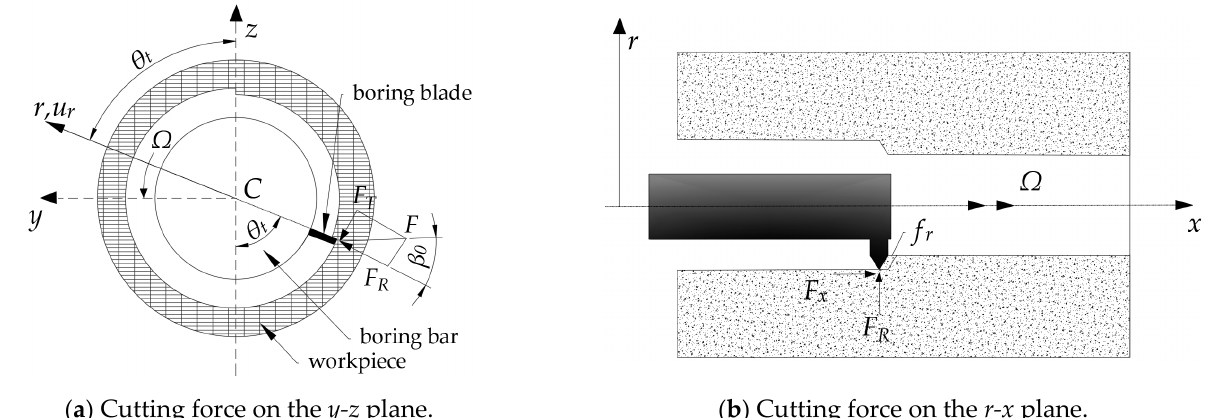
Figure 3. Model of the cutting force in the boring.